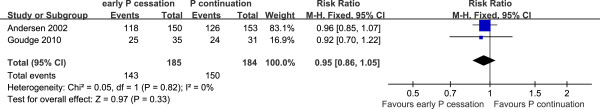
Live birth rate of women who underwent early P cessation versus P continuation after IVF/ICSI.